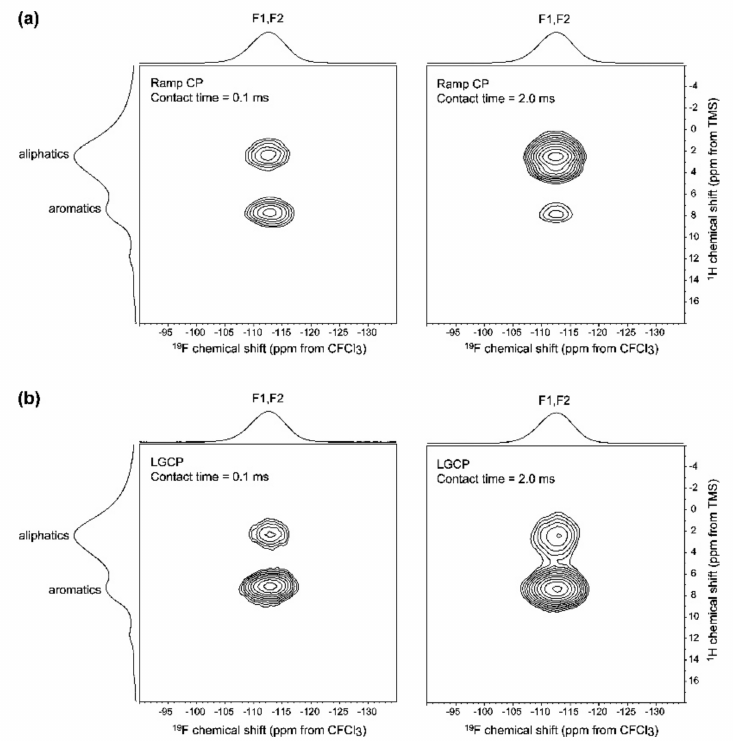
Figure 9. ( a ) 1 H- 19 F CP-HETCOR spectra of a 30% w/w amorphous dispersion of diflunisal (VI) in PVP; ( b ) 1 H- 19 F LGCP-HETCOR spectra obtained under the same conditions, except with the use